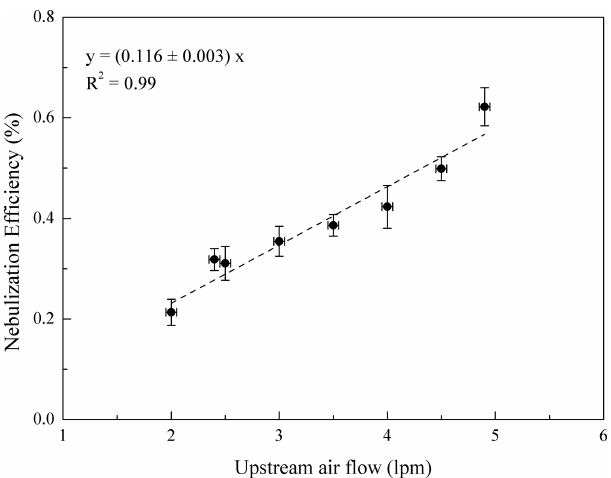
Figure 6. Correlation curve between the number of E. coli bacte- ria injected in ChAMBRe by the BLAM nebulizer and the average count on the four petri dishes exposed in each experiment. The in- jected bacteria correspond to the product of the concentration (i.e., CFUmL − 1 ) in the bacterial suspension for the volume of liquid (2mL) introduced in the